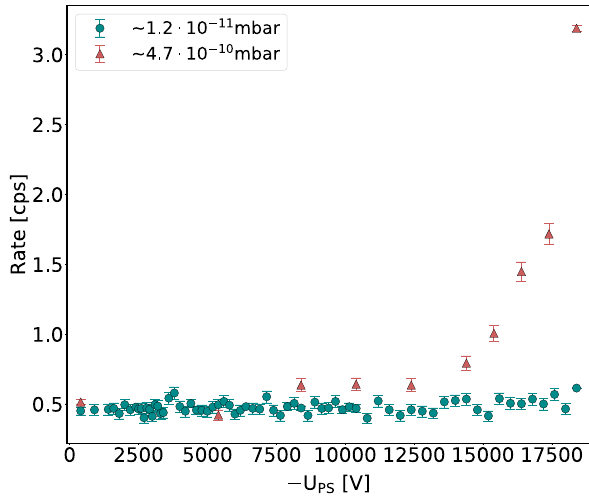
Fig. 13 Background rate during a long-term measurement at nominal spectrometer conditions (setting E, Table 1). Shown for comparison are theaverageratesfrommeasurementstakenwithalowerLFCSmagnetic field in which the ion gauge state was toggled (settings F and G, Table 1). For all three measurements here, two pixel rings (pixels 4–15 and 136–147, see Fig. 8b) which were damaged by a Penning discharge during one of the tests before the long-term measurement are